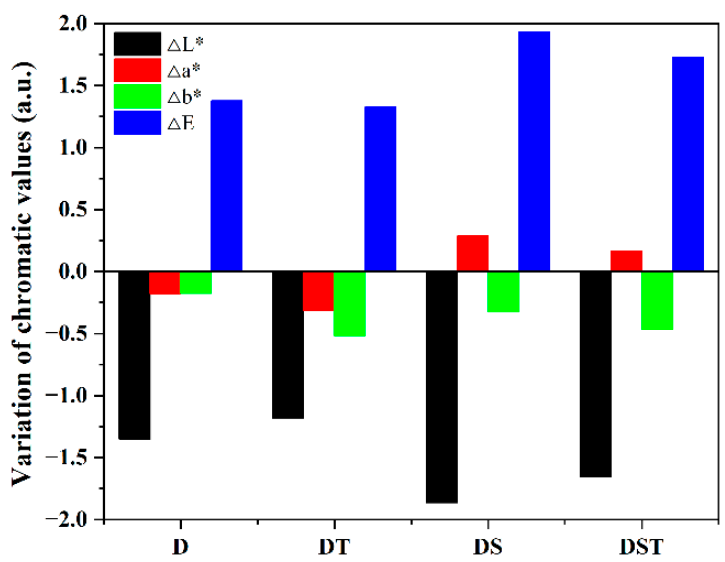
Figure 6. Variation in chromatic values before and after treatment.